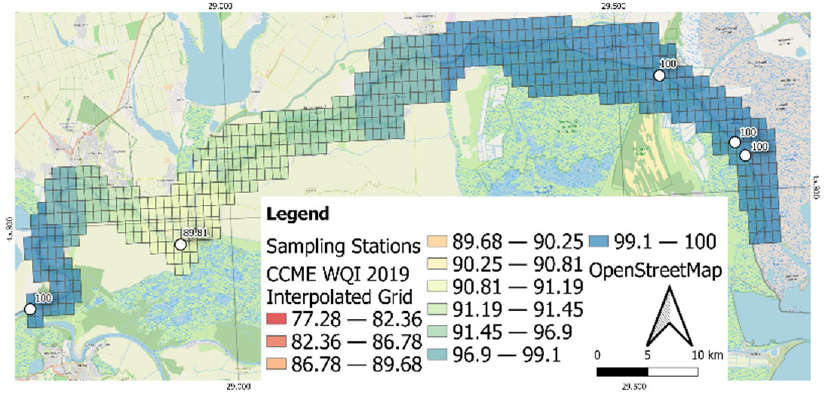
Figure 10. CCME WQI trends in 2019 on the Chilia branch. Taking into account the classification of water quality based on CCME WQI and regular WQI calculation [3] (Tables 4 and 7), Table 8 presents a comparison between the results obtained by applying both indices. Table 7. Surface water quality classes according to WQI values [3,5,18,37].